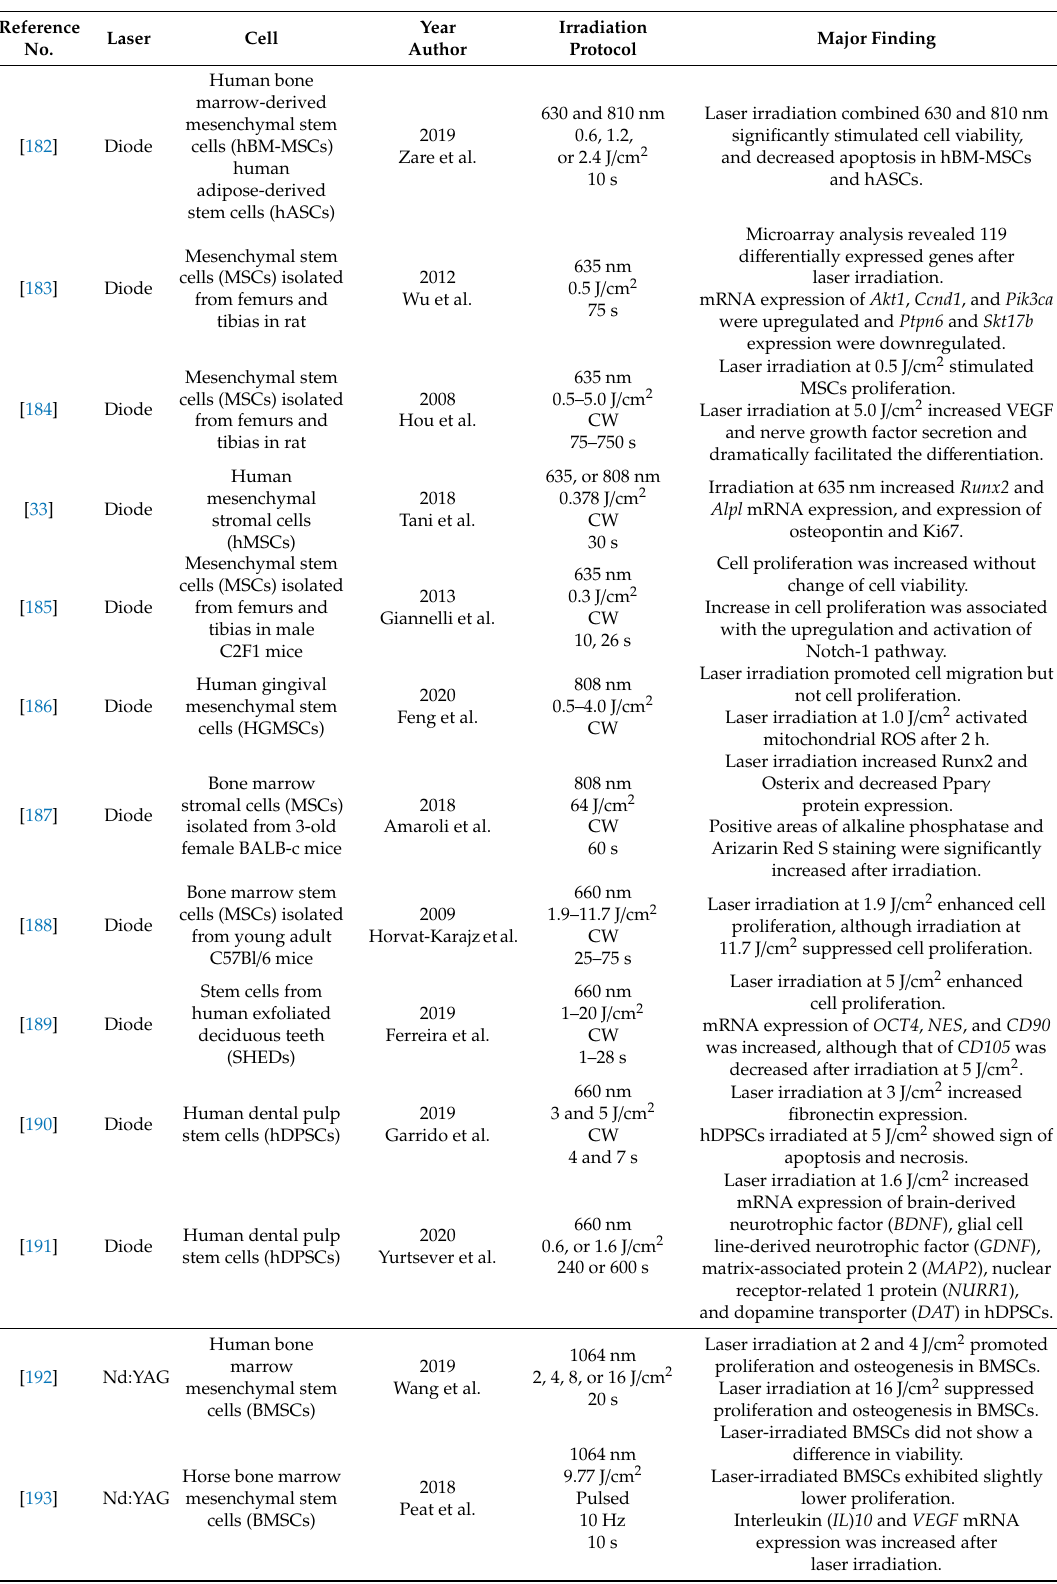
Table 9. Summary of the e ff ects of laser irradiation on mesenchymal stem cells. Reference